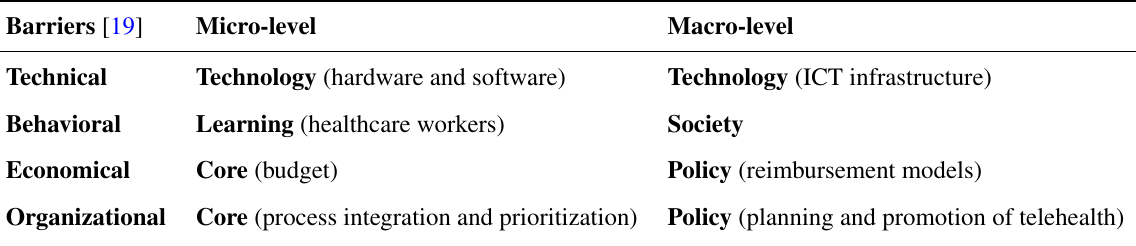
Table 3. Relationship between Tanriverdi and Iacono [19] and Khoja et al.